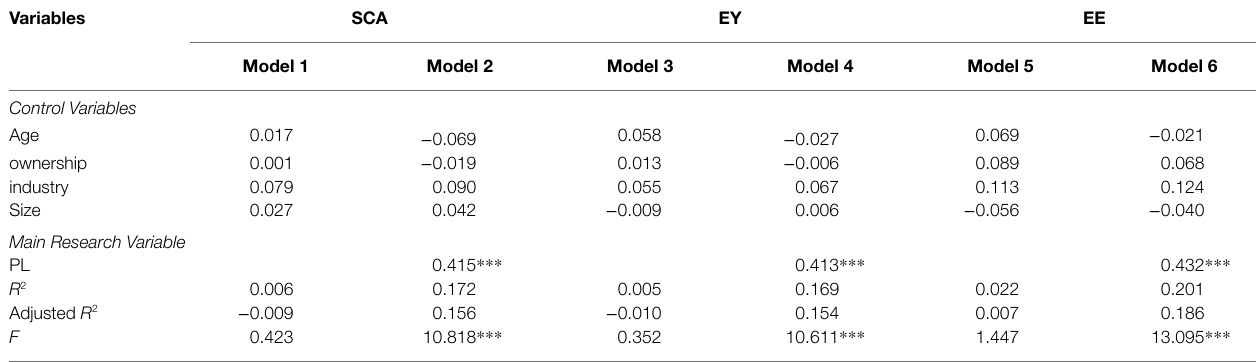
TABLE 4 | Results of multiple linear regression.